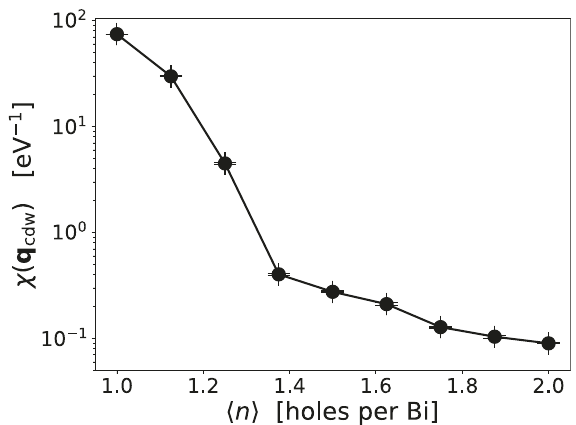
Fig. 6 Change in susceptibilities upon doping. Results were collected on an L = 4 lattice at inverse temperature β = 18 eV − 1 . The charge susceptibility χ 6s,6s ( q cdw ) monotonically decreases upon doping. The error bars in this fi gure are the standard deviation of the mean of our